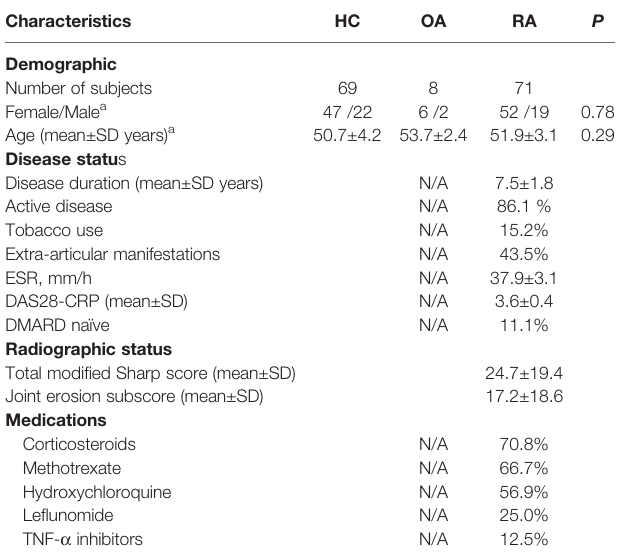
TABLE 1 | Demographic and clinical characteristics of the study